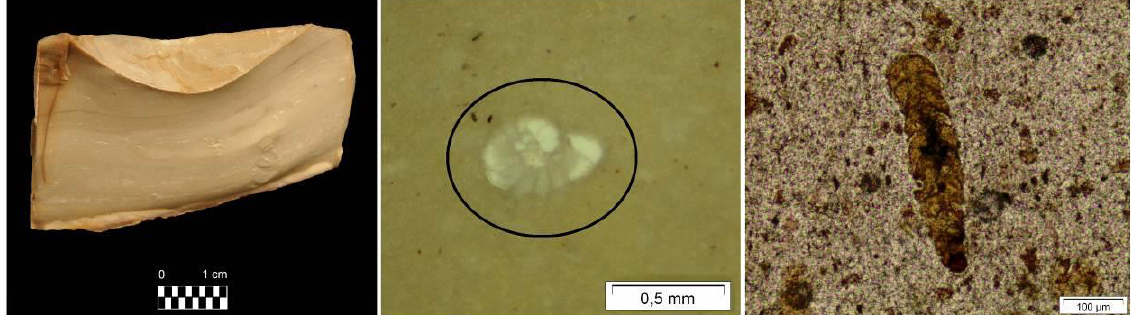
Figure 9. Visu view (left), macroscopic view (centre) and microscopic view (right) of a URC Formation